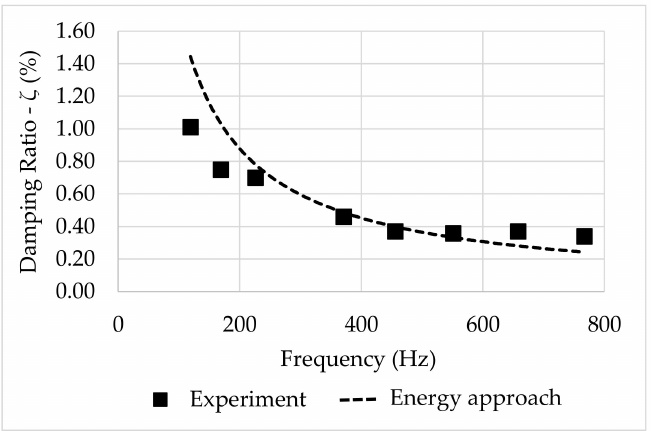
Figure 19. Damping ratio: Curve fitting from the energy